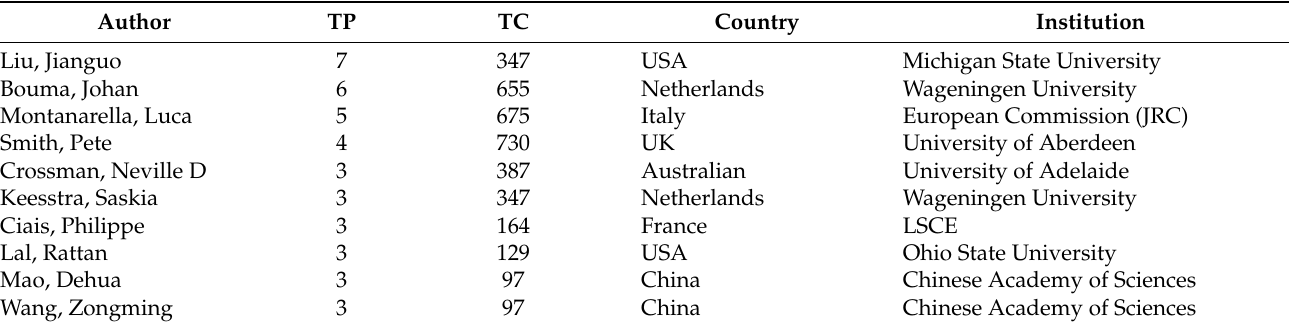
Table 4. Most prolific authors (Top 10).